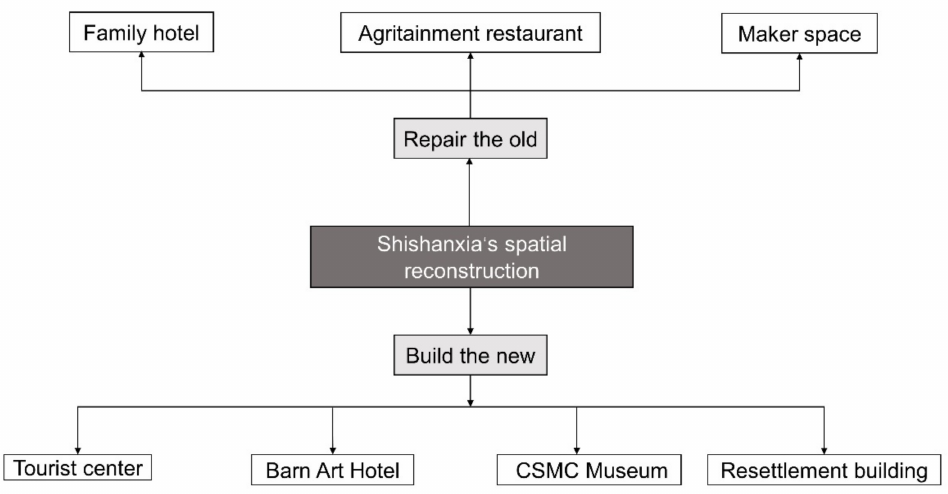
Figure 1. Preliminary analysis of Shishanxia space